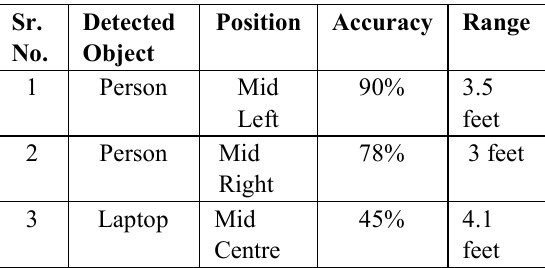
Table I. The summary of output generated for frame 1.